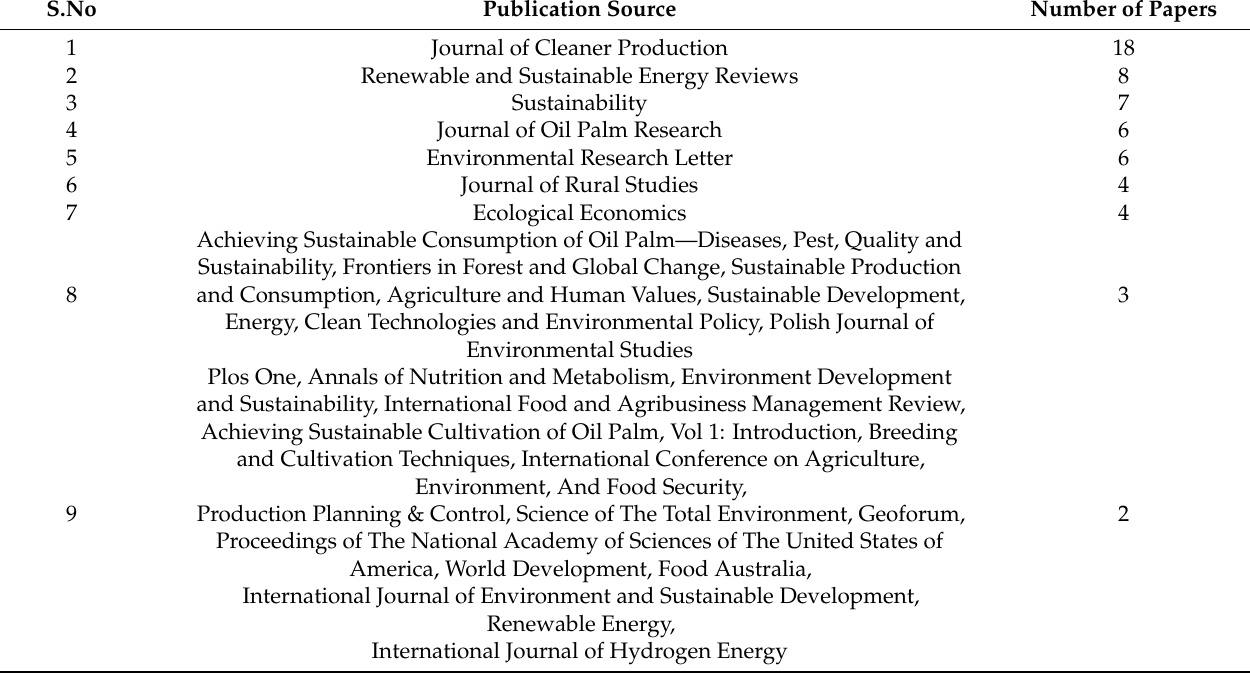
Table 2. Source of publication.